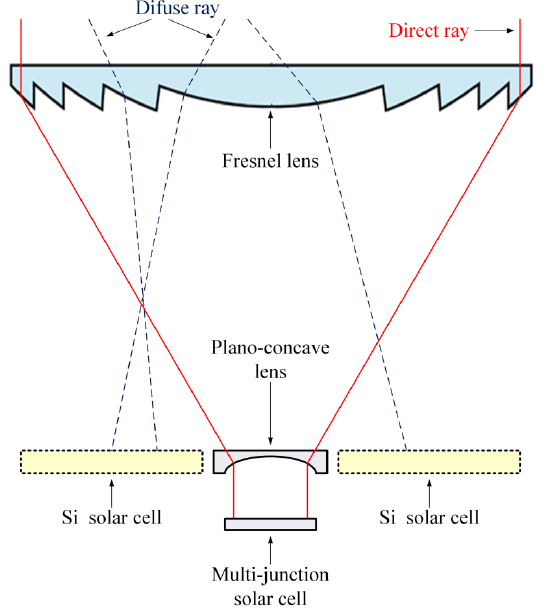
Figure 4. Design of the proposed CPV unit with the SOE and low ‐ cost cell.